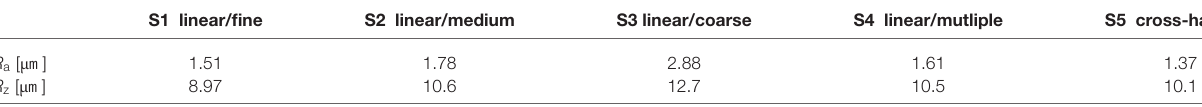
TABLE 1 | 2D roughness data from line scans after grinding.